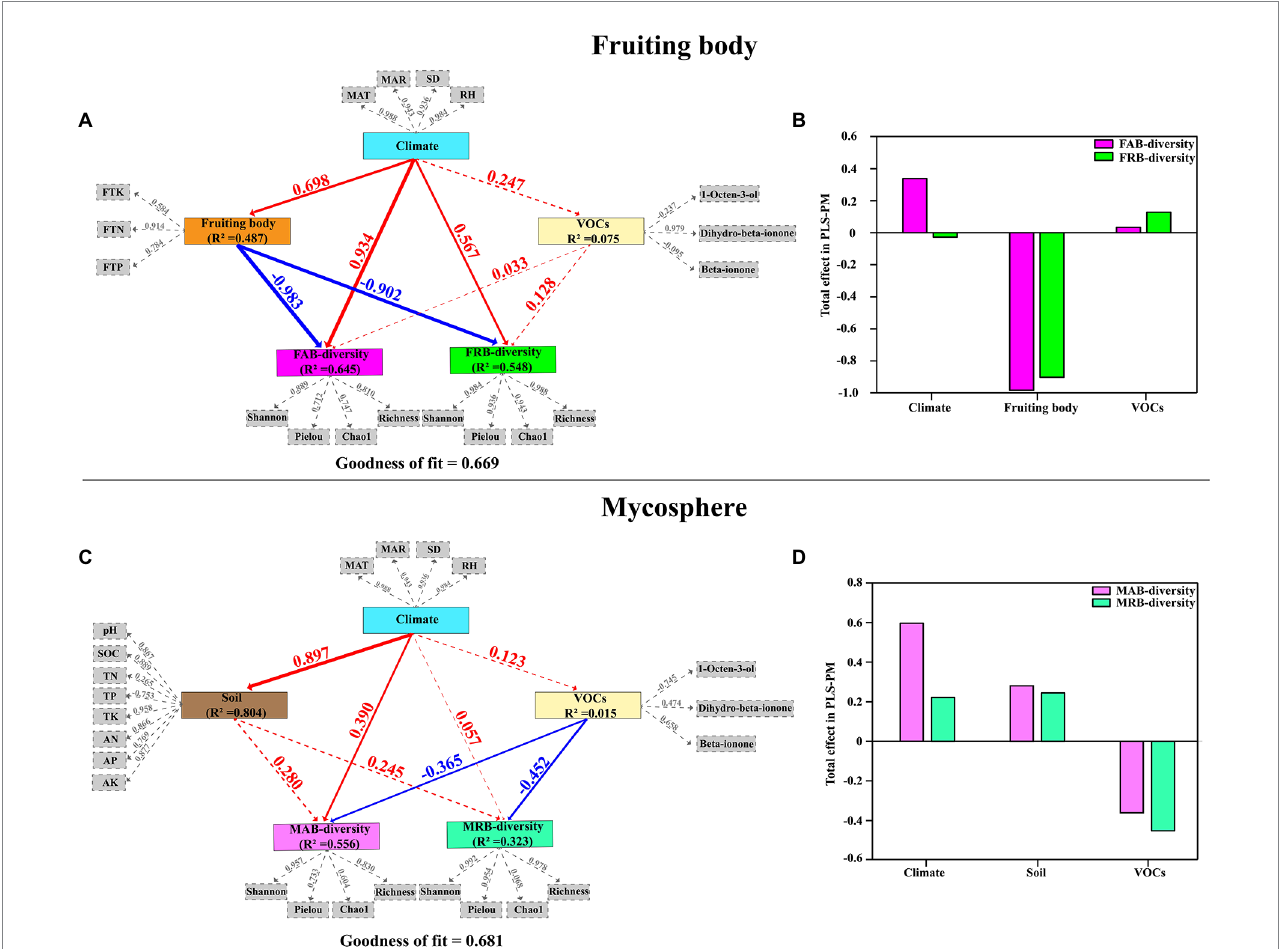
FIGURE 7 Partial least squares path modeling (PLS-PM) disentangling main pathways of climate, soil physicochemical properties, volatile organic compounds, and the chemical composition of the fruiting body on the diversity of abundant and rare bacteria in the fruiting body and mycosphere (A,C) ; and the total effects of each variable on the diversity of abundant and rare bacteria in the fruiting body and mycosphere (B,D) . Each solid box represents a latent variable, and each gray dashed box represents an observed variable. The numbers on the arrow lines represent the normalized path coefficients, and the R 2 values represent the variance of the dependent variable explained by the internal model. The width of the arrow reflects the magnitude of the path coefficient. The blue and red arrows represent positive and negative impacts, respectively. Solid and dashed lines indicate a significant ( p < 0.05) and no significant ( p > 0.05) correlation, respectively. The goodness of fit (Gof) statistic was used to test the model, and the Gof values of the fruiting body and microsphere soil were 0.669 and 0.681, respectively. MAT, mean annual temperature; MAR, mean annual rainfall; RH, relative humidity; SD, sunshine duration; FTN, total nitrogen of the fruiting body; FTP, total phosphorus of the fruiting body; FTK, total potassium of the fruiting body; pH, soil pH; SOC, soil organic matter; TN, soil total nitrogen; TP, soil total phosphorus; TK, soil total potassium; AN, soil available nitrogen; AP, soil available phosphorus; AK, soil available potassium; FAB- diversity, alpha diversity index of abundant bacteria in fruiting body; FRB-diversity, alpha diversity index of rare bacteria in fruiting body; MAB-diversity, alpha diversity index of abundant bacteria in mycosphere; MRB-diversity, alpha diversity index of rare bacteria in